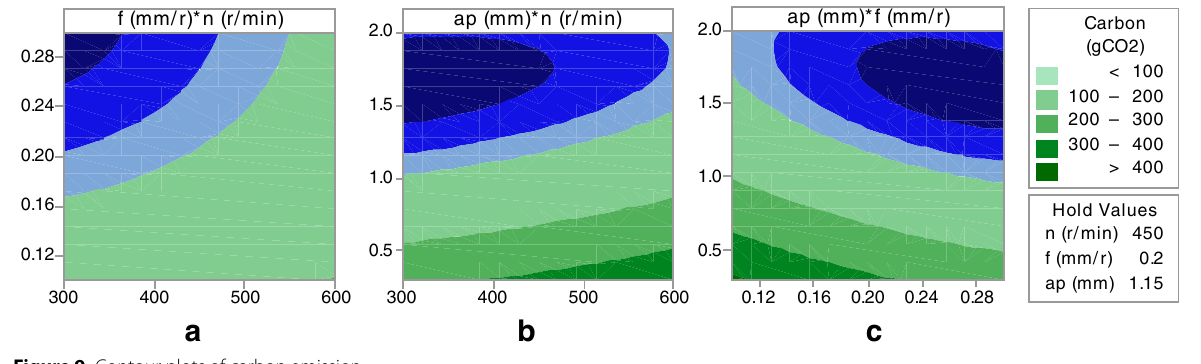
Figure 9 Contour plots of carbon